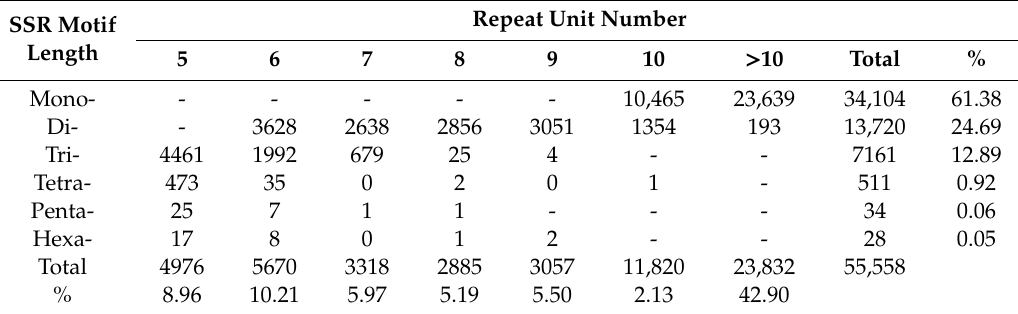
Table 5. Summary of repeat unit numbers in avocado expressed sequence - simple sequence repeats tag (EST-SSR)